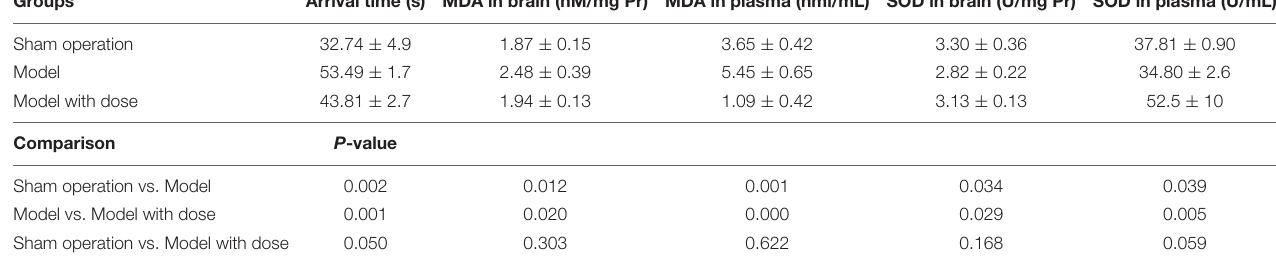
TABLE 1 | Data from the water maze and the biochemical analyses. Groups